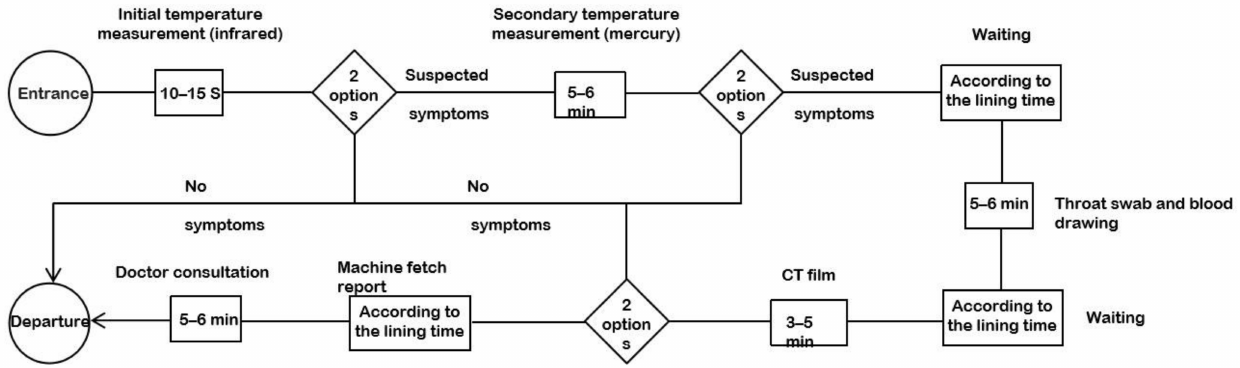
Figure 3. Community virus-testing